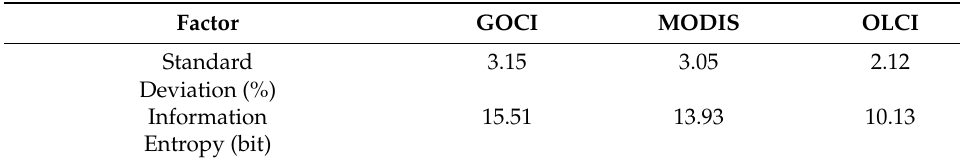
Table 7. Spatiotemporal continuity